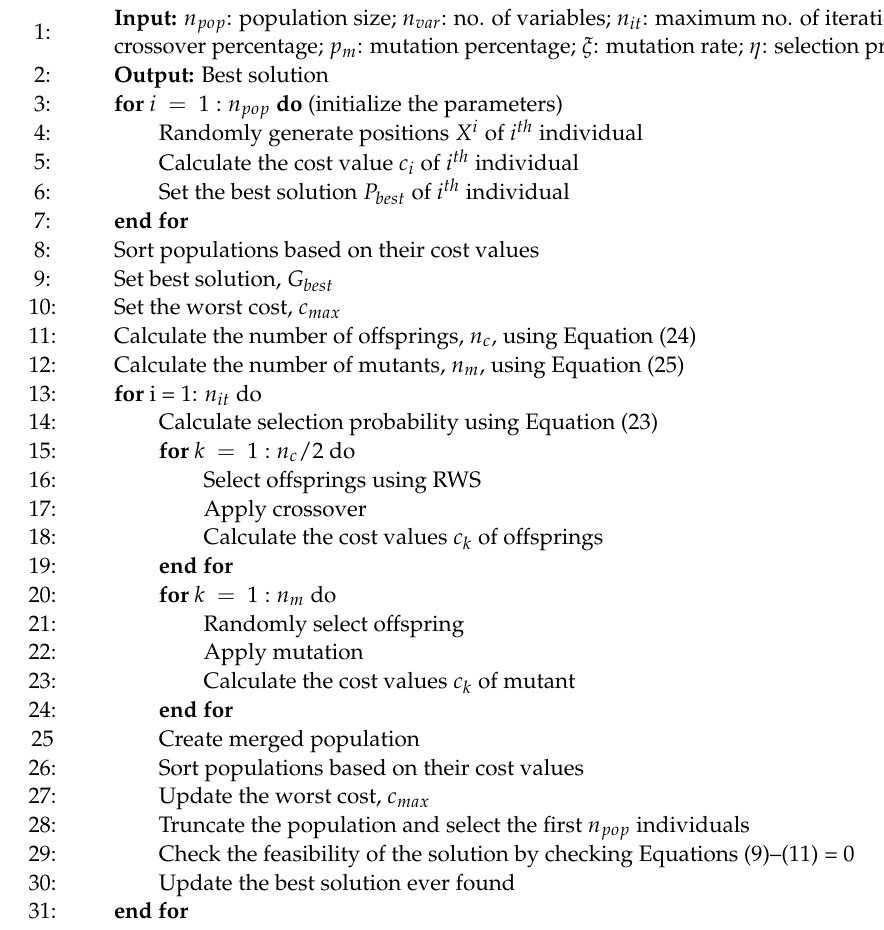
Algorithm 2. Genetic Algorithm.